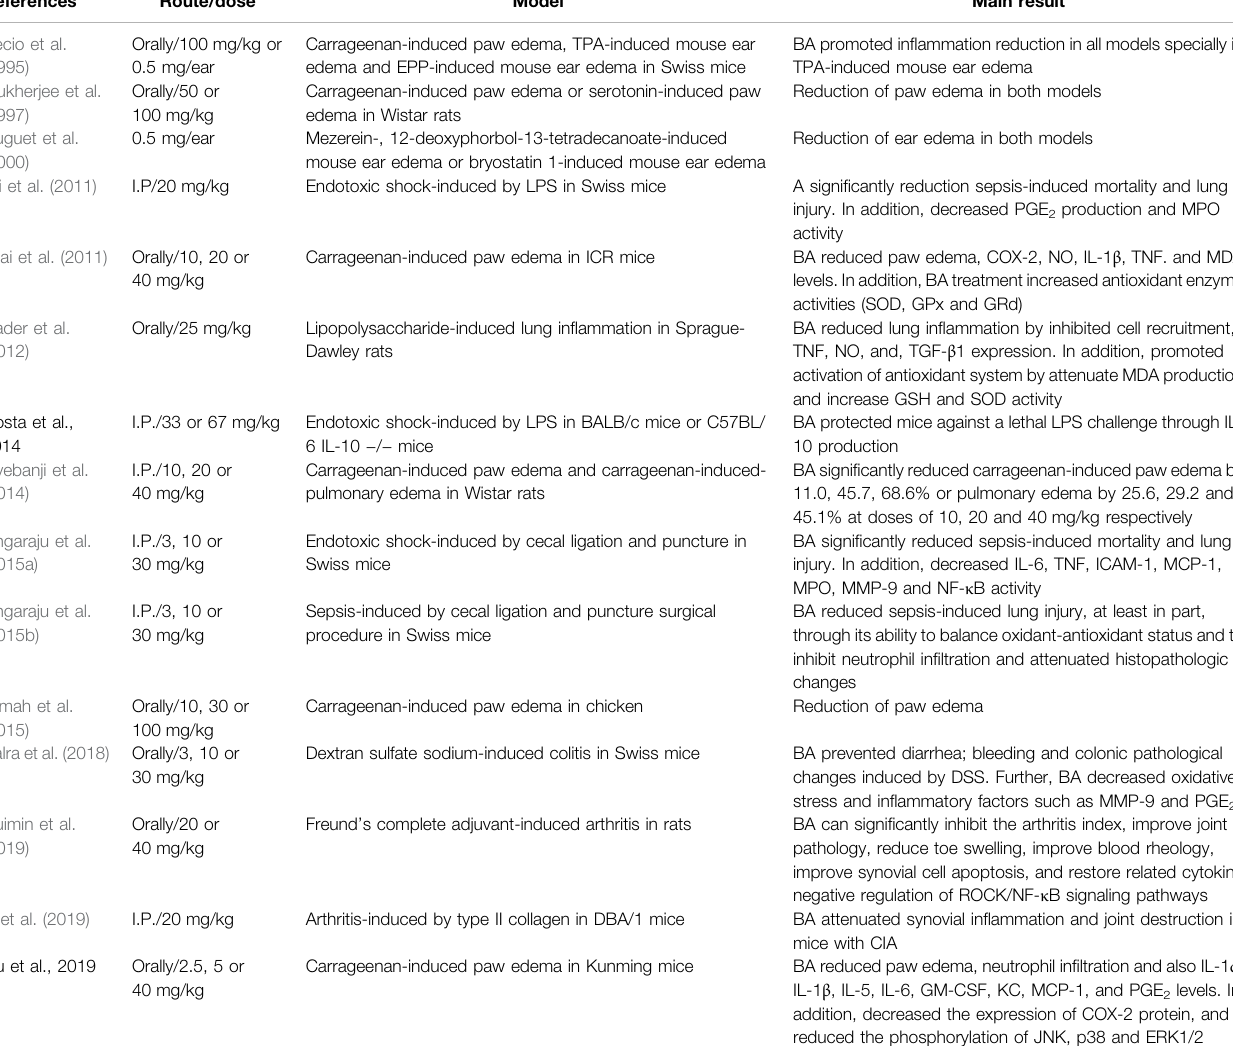
TABLE 2 | In vivo immunomodulatory activity of betulinic